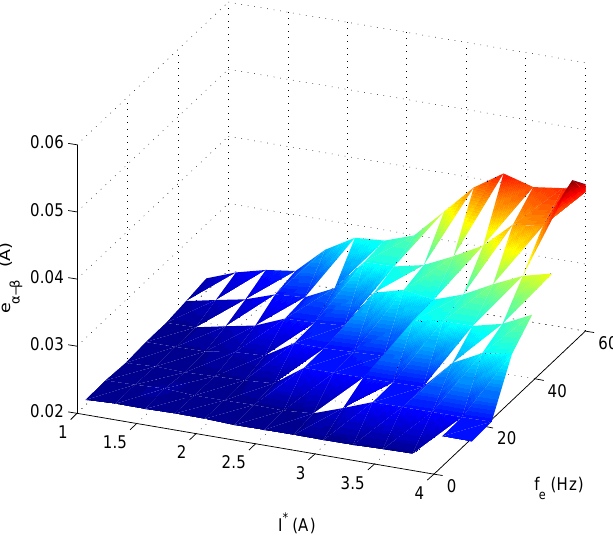
Figure 7. Performance map for the proposed controller (C3) using the best set of VVV for each operating